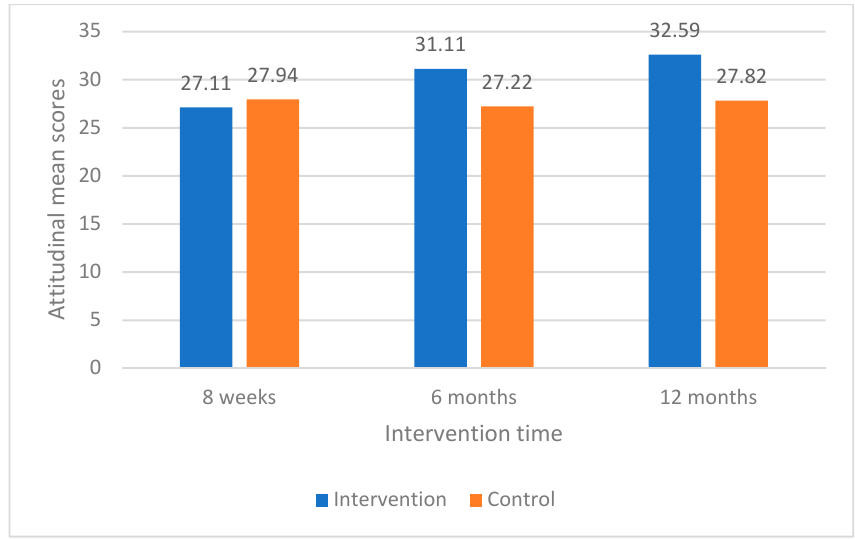
Figure 2. Changes in mean scores for importance and intention to control baby sugar snacking for intervention and control groups.